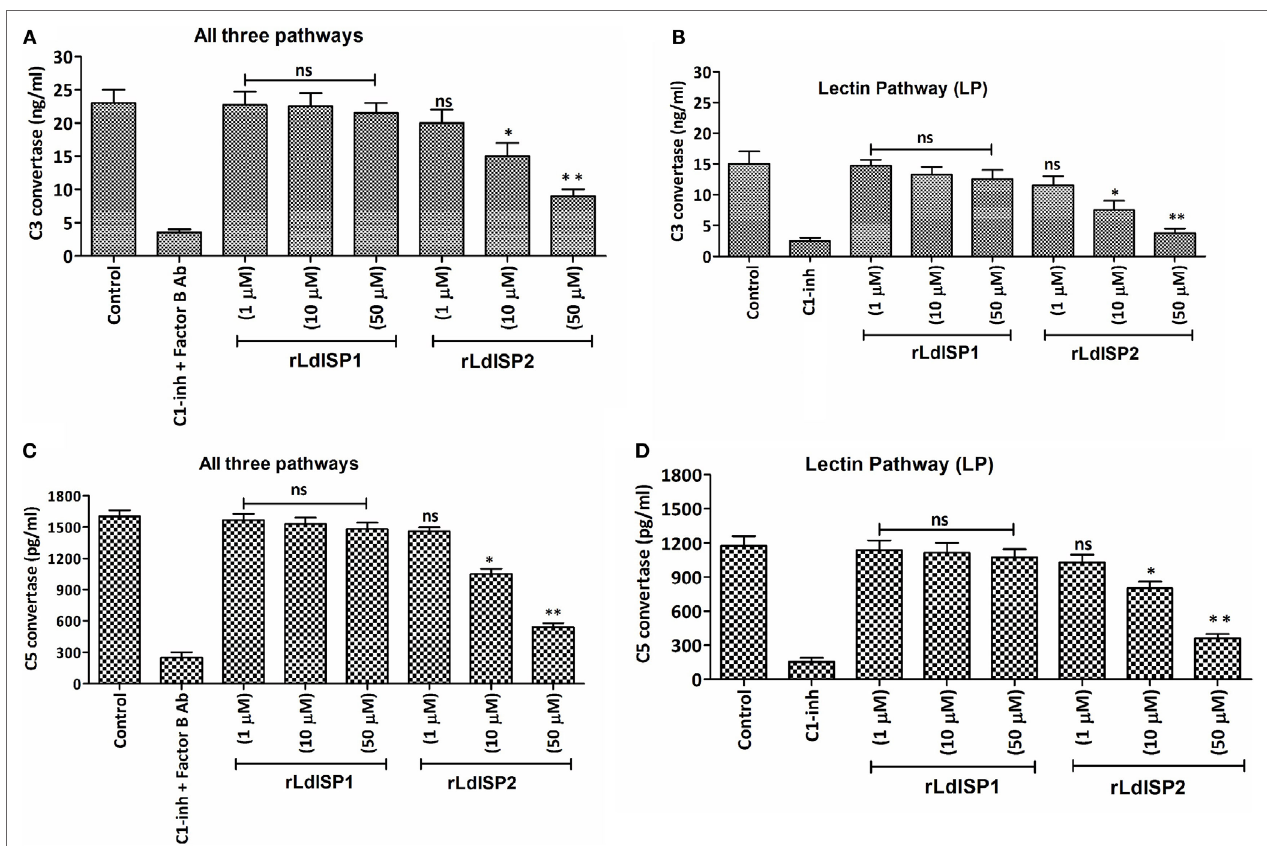
FigUre 5 | Effect of LdISPs on the formation of C3 convertase (C3c) and C5 convertase (C5c). The activity of C3c and C5c was measured to monitor the formation of C3c and C5c via all complement pathways or specifically via lectin pathway in presence or absence of rLdISP1and rLdISP2. Normal human serum or lectin pathway-specific serum was incubated with different concentration (0–50 µM) of rLdISP1 and rLdISP2, C1-inhibitor (C1-inh) or C1-inh + factor B Ab at 37°C for 2 h. Leishmania promastigotes (~2 × 10 6 ) were added to the different group of treated serum and incubated at 30°C with shaking at 300 rpm for 5–10 min. Formation of C3c (a,B) and C5c (c,D) were accessed by sandwich ELISA. The experiments were performed in triplicate and data are means ± SD from three separate experiments. An asterisk (*) denotes P ≤ 0.05, double asterisk (**) denotes P ≤ 0.001 and “ns” denotes non-significant as compared to control, Kruskal–Wallis test with Dunn’s multiple comparison